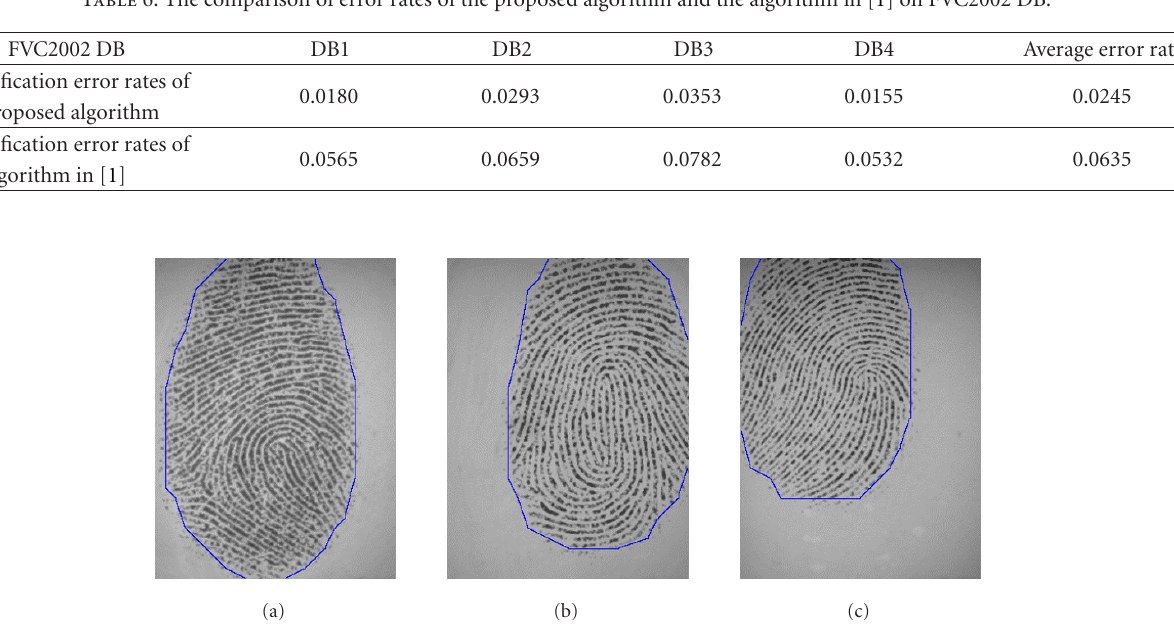
Figure 28: Segmentation results of three fingerprints from FVC2002 DB4: (a) is from the training data, (b) and (c) are from the test data.